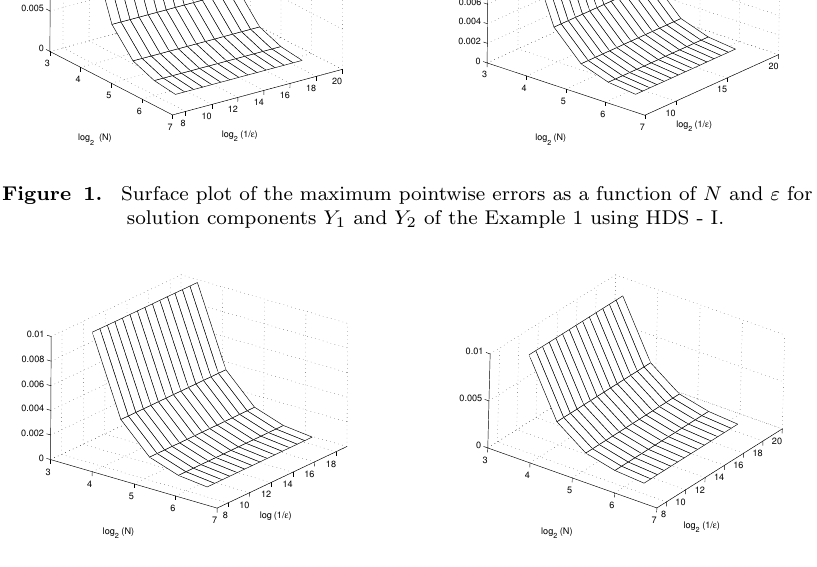
Figure 2. Surface plot of the maximum pointwise errors as a function of N and ε for the solution component Y 1 and Y 2 of the Example 1 using HDS - II.